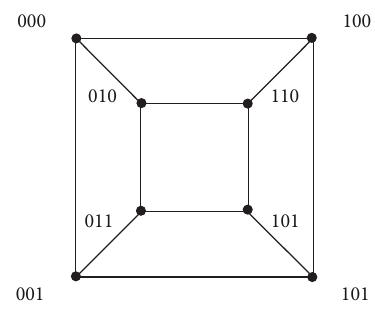
Figure 1: Te 3-dimensional hypercube Q